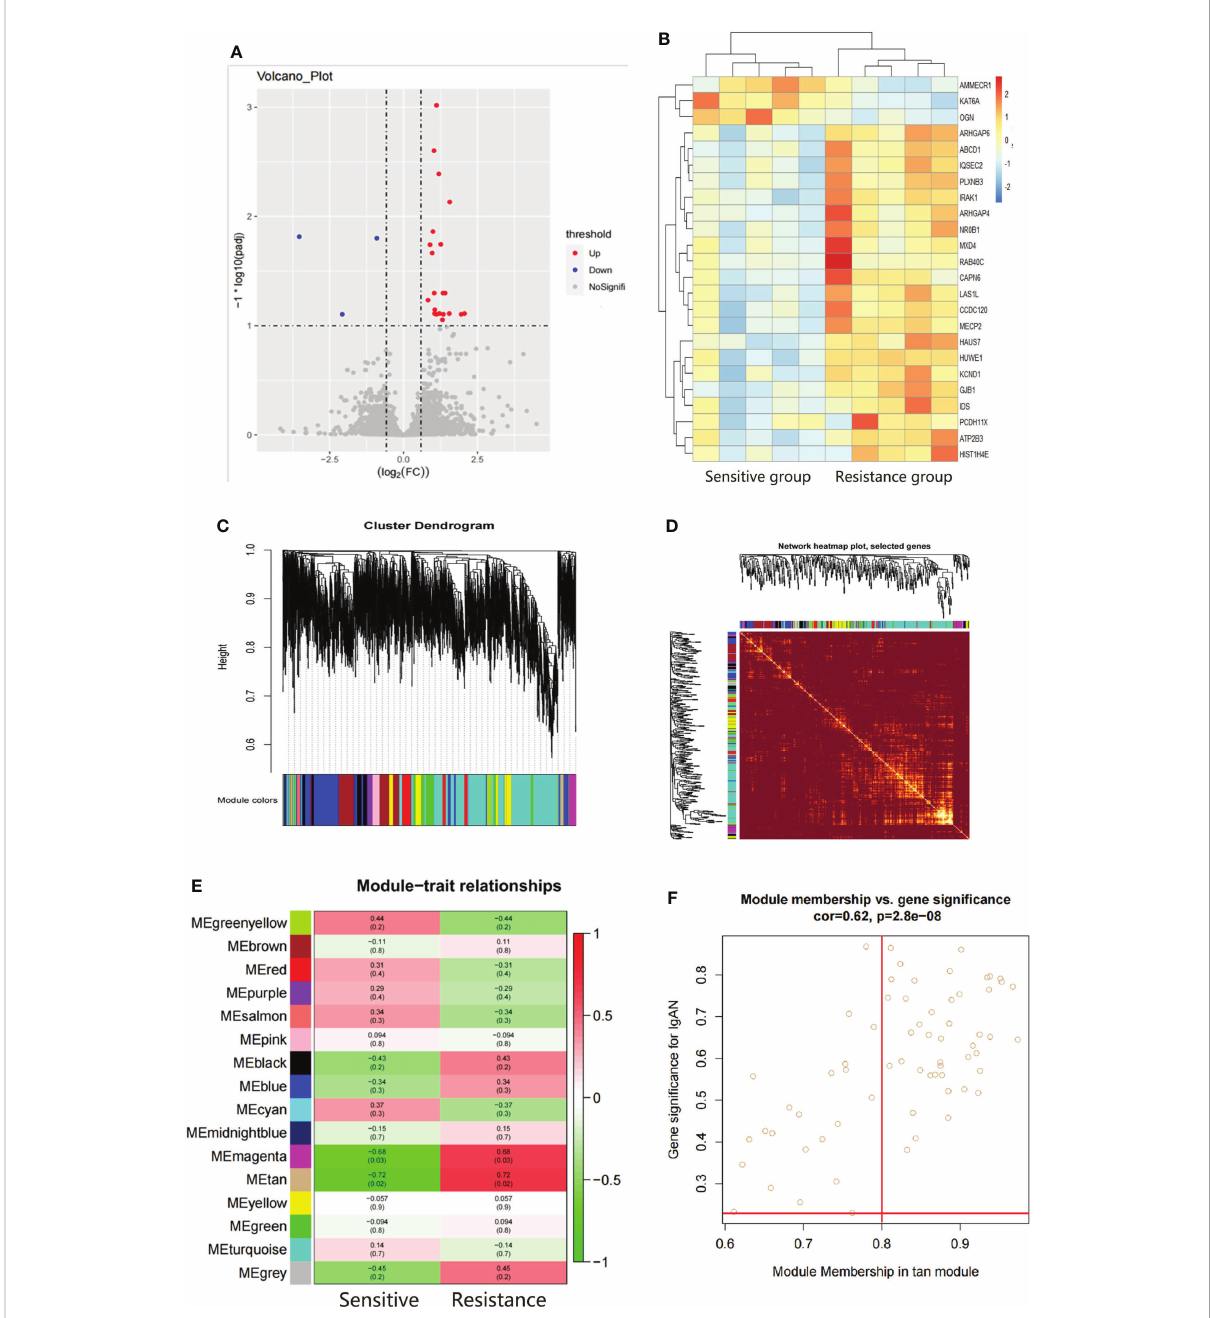
FIGURE 3 Hub gene screening by DEGs screening and WGCAN. (A, B) Volcano plot and heatmap of DEGs between the sensitive group (n=5) and the resistant group (n=5). (C) Gene dendrogram. (D) Heatmaps visualizing 400 randomly selected genes in the network to depict the topological overlap matrix. (E) Heatmap of module – trait relationships. (F) The distribution of GS and MM was presented as a scatter diagram in the tan